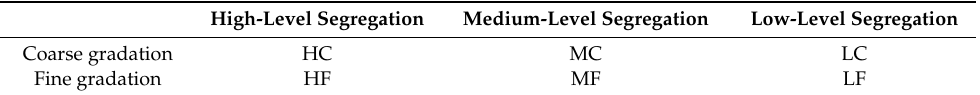
Table 1. Label of aggregate gradations.